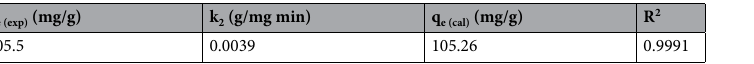
Table 6. Biosorption kinetics constants of strontium ions on Mg-treated biomass for the PSO model at optimized conditions (M